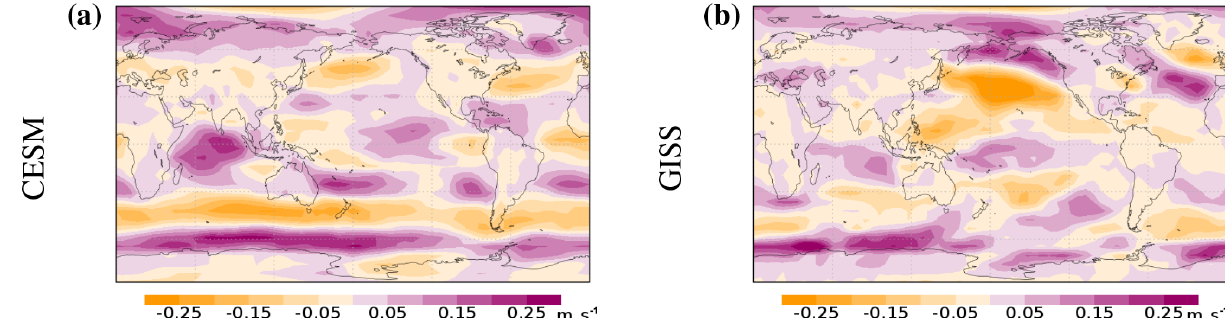
Figure 8. Maps of zonal wind anomalies for the 10 years after the 12 main volcanic eruptions of the LM. (a) Average of simulations from the CESM subensemble. (b) Average of simulations from the GISS subensemble.